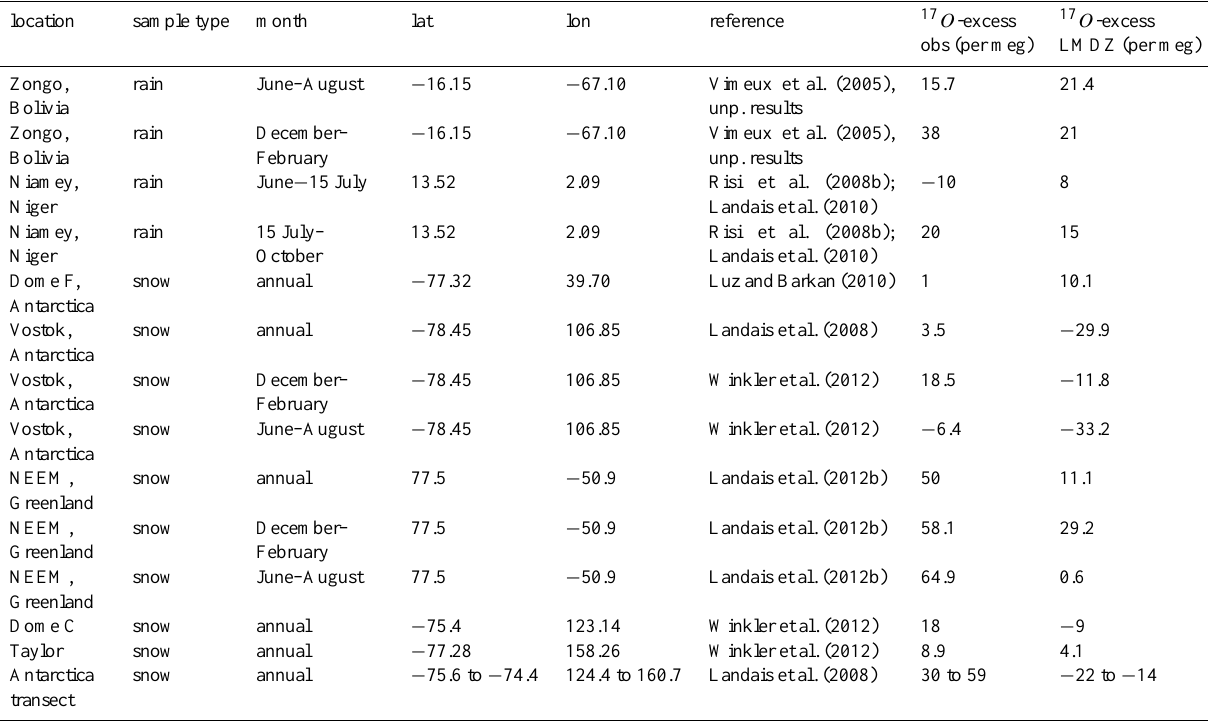
Table 2. Precipitation 17 O -excess simulated by LMDZ, compared to various additional measurements done at LSCE. location sample type month lat lon reference 17 O -excess 17 O -excess